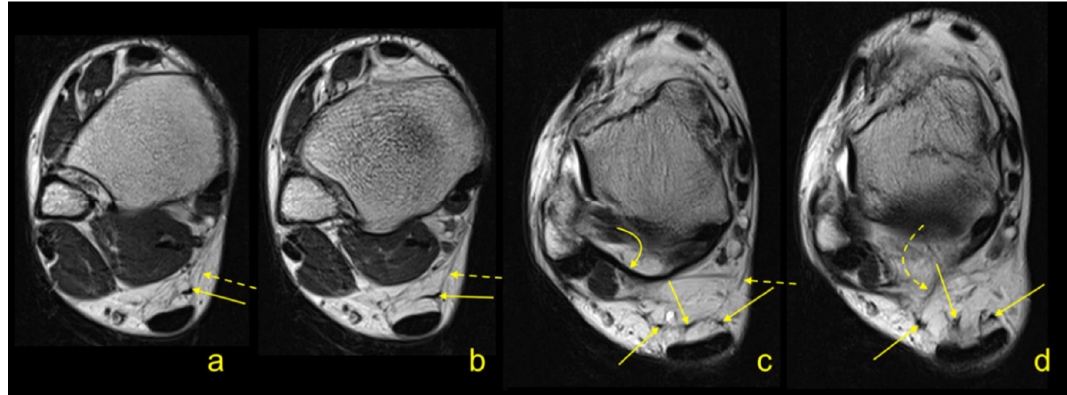
Figure 8. ( a , b )—a 20-year-old patient with clinical suspicion of tenosynovitis. ( c , d )—a 19-year-old patient with clinical suspicion of Achilles tendinopathy. ( a – d )—PD weighted images. The plantaris tendon branches (straight arrow) anteriorly to the Achilles tendon. Communication between the plantaris tendon and the FR can be seen (dashed arrow). A thick FTCL (curved arrow) with communication with one of the terminal branches (curved dashed arrow) from the plantaris tendon can be noticed.